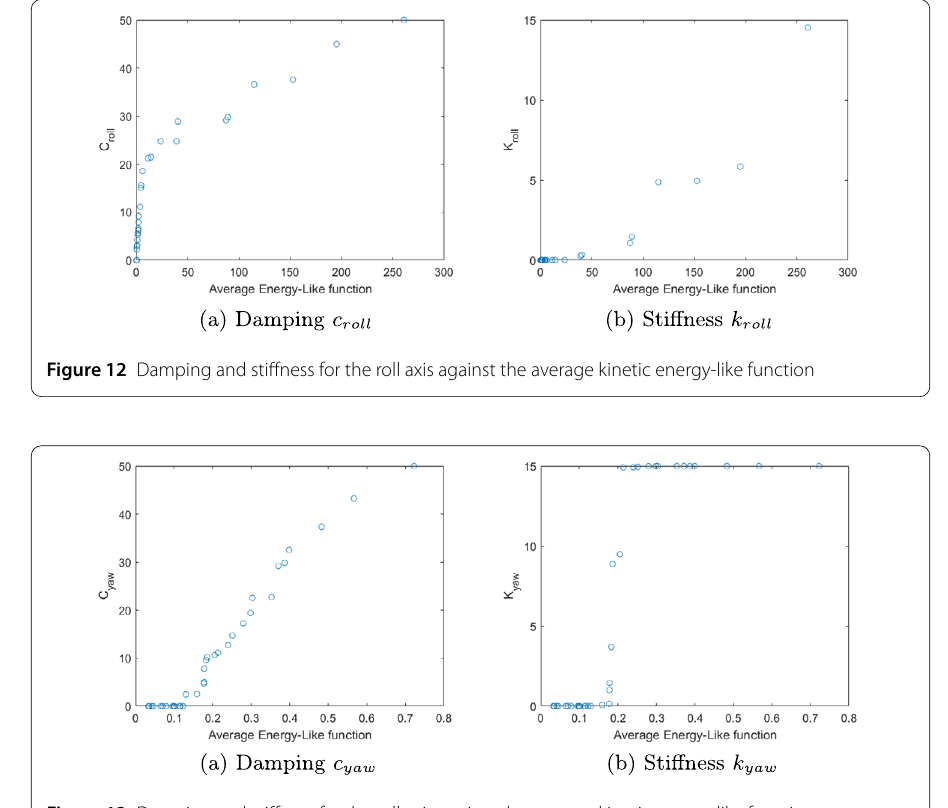
is close to zero initially and increases exponentially with a decreasing slope as its value reaches about 0.7. The values of k yaw are close to zero initially and quickly approach the value of 15 once the kinetic energy-like function reaches 0.2. Each of the four parameters exhibits a nonlinear phenomenon, which could be mathematically described by a